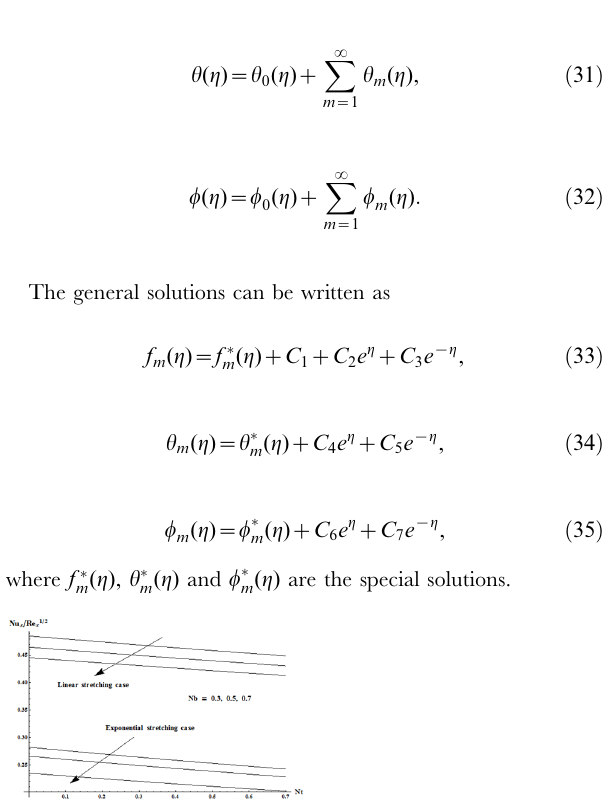
Eckert number Ec and radiation